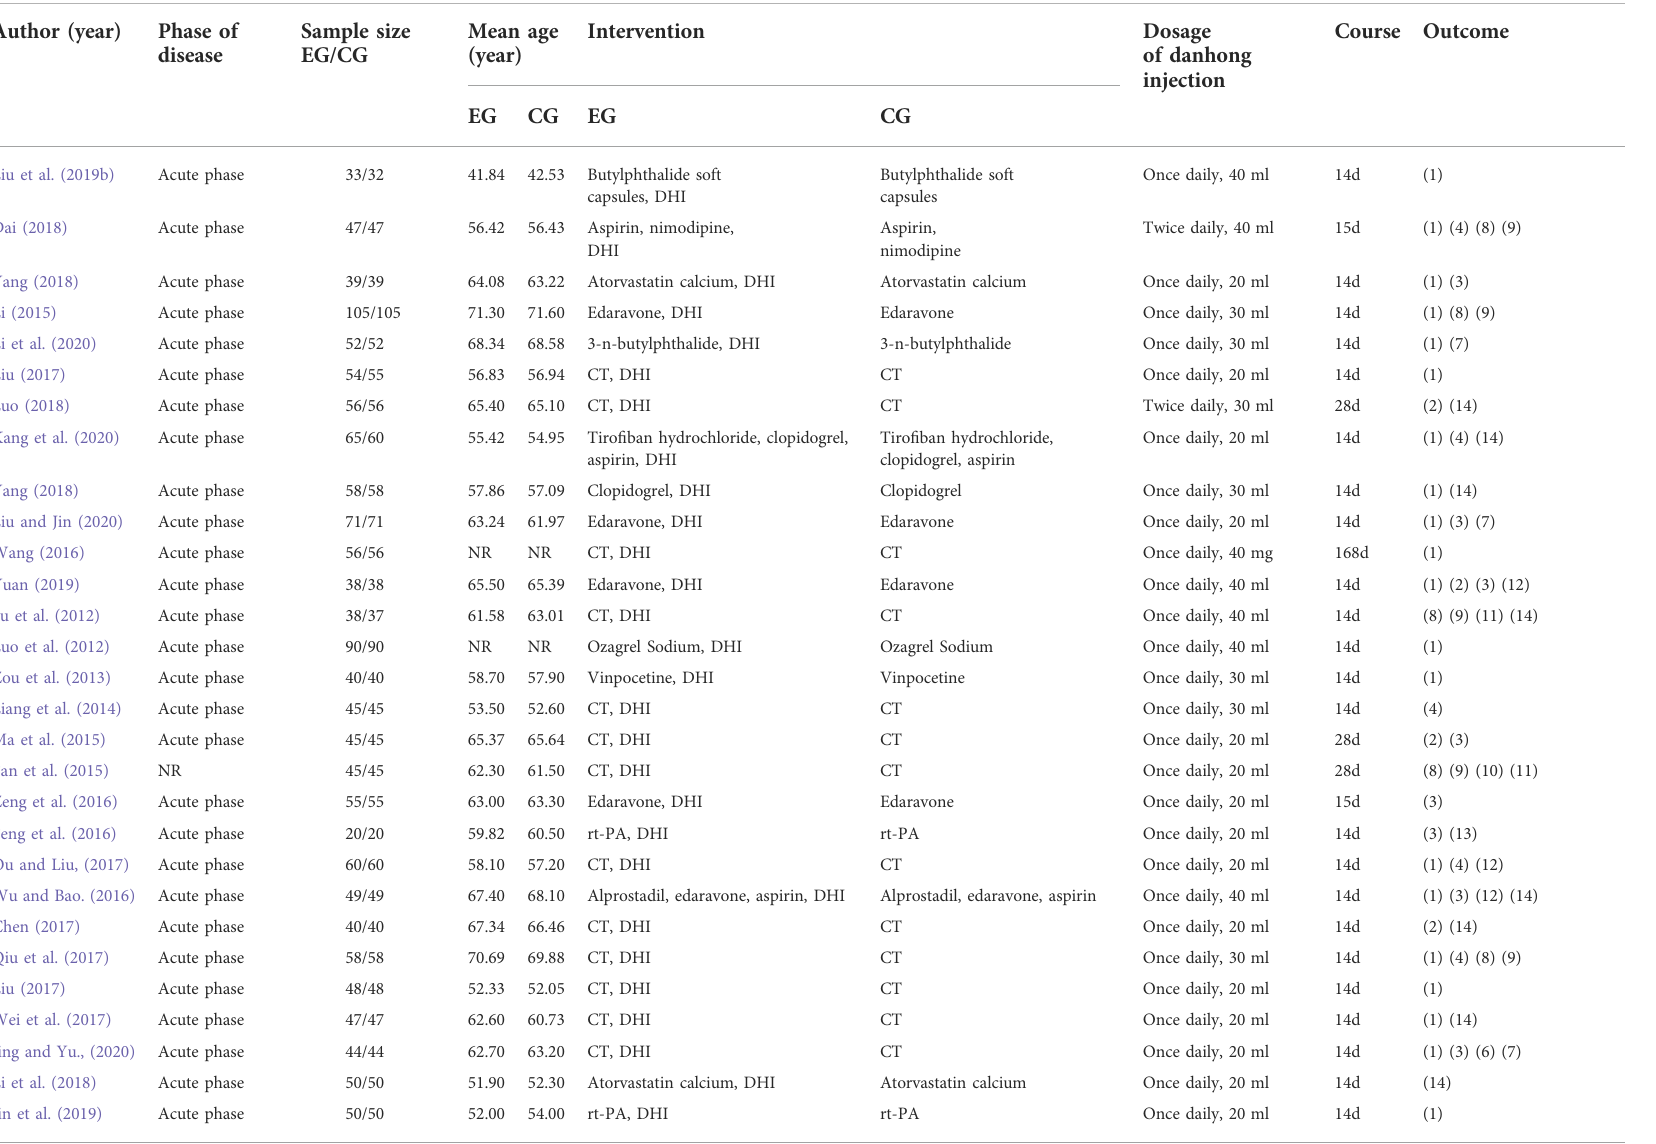
TABLE 1 ( Continued ) Baseline characteristics of included randomized controlled